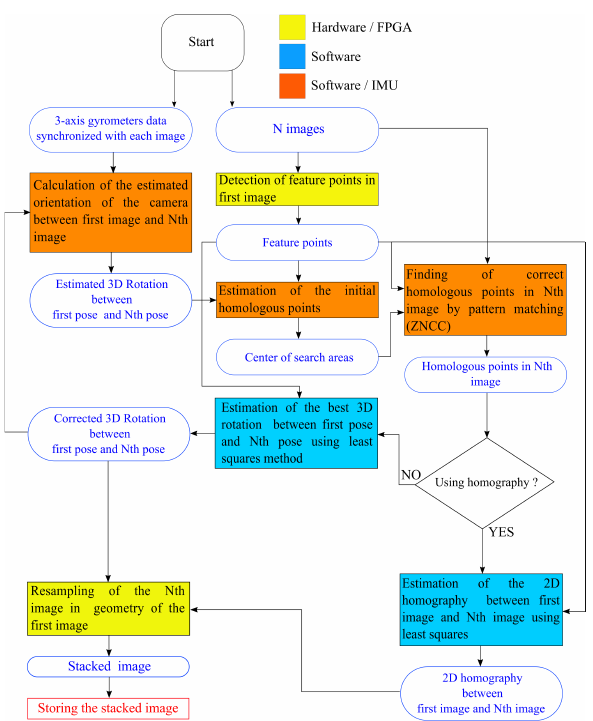
Figure 3. Architecture of the algorithm (hardware/software co- design).